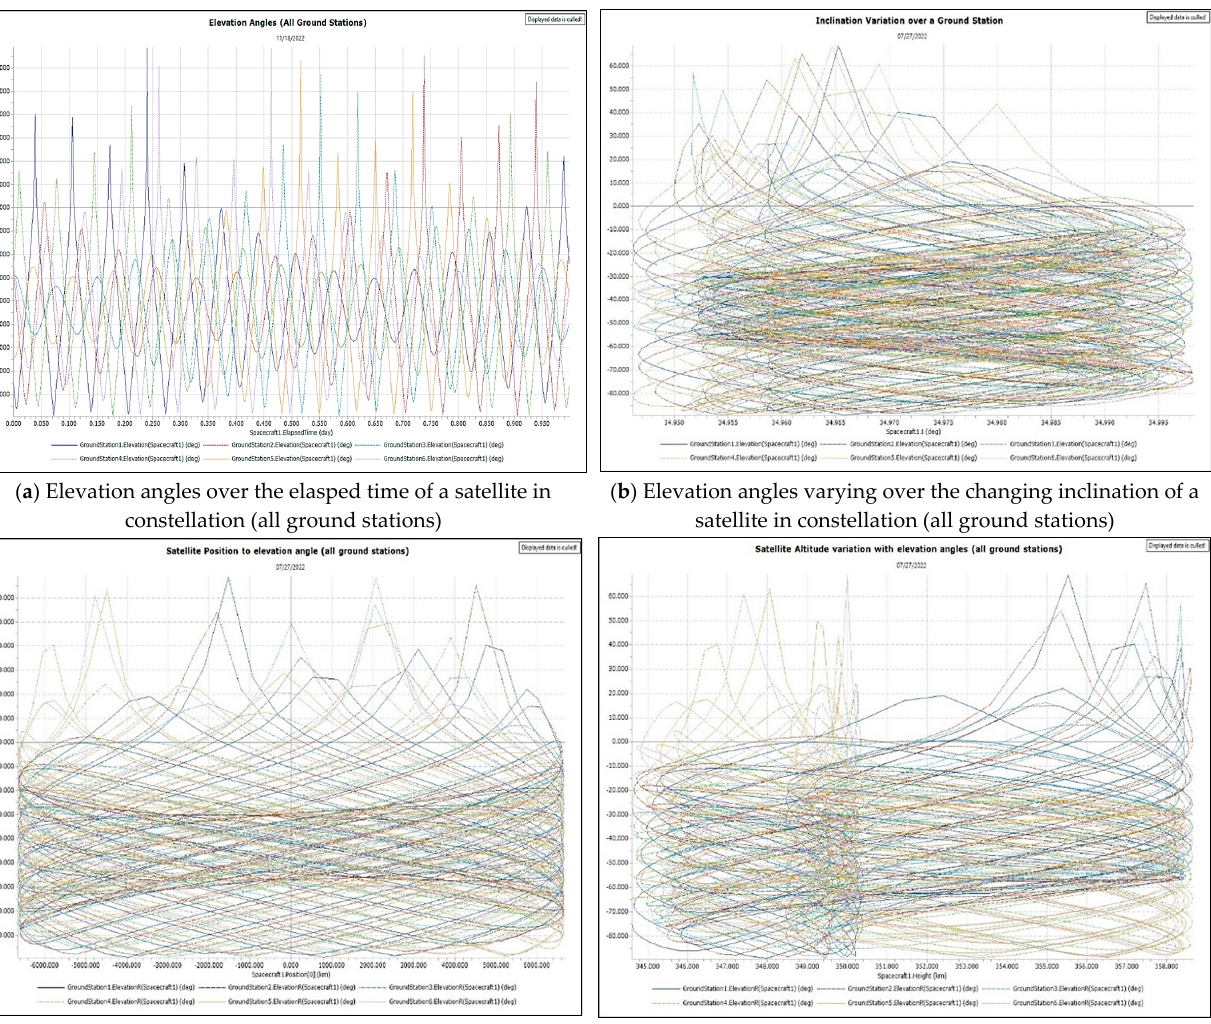
Figure 13. Variation of elevation angles with satellite parameters.